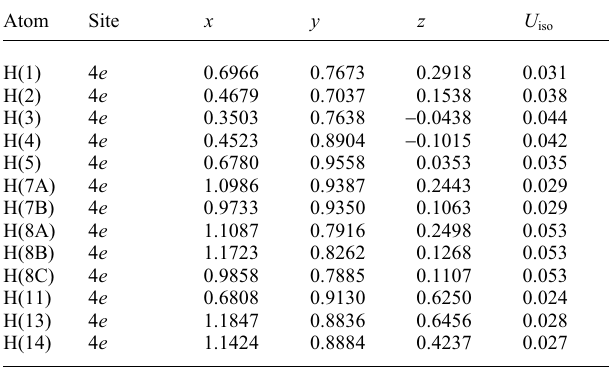
Table 2. Atomic coordinates and displacement parameters (in Å 2 ) .